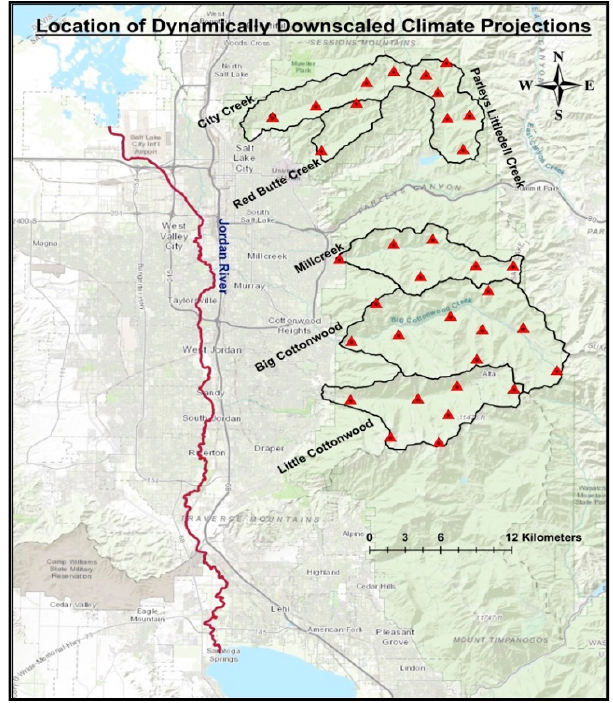
Figure 4. Locations for which dynamically downscaled climatic projections have been estimated.